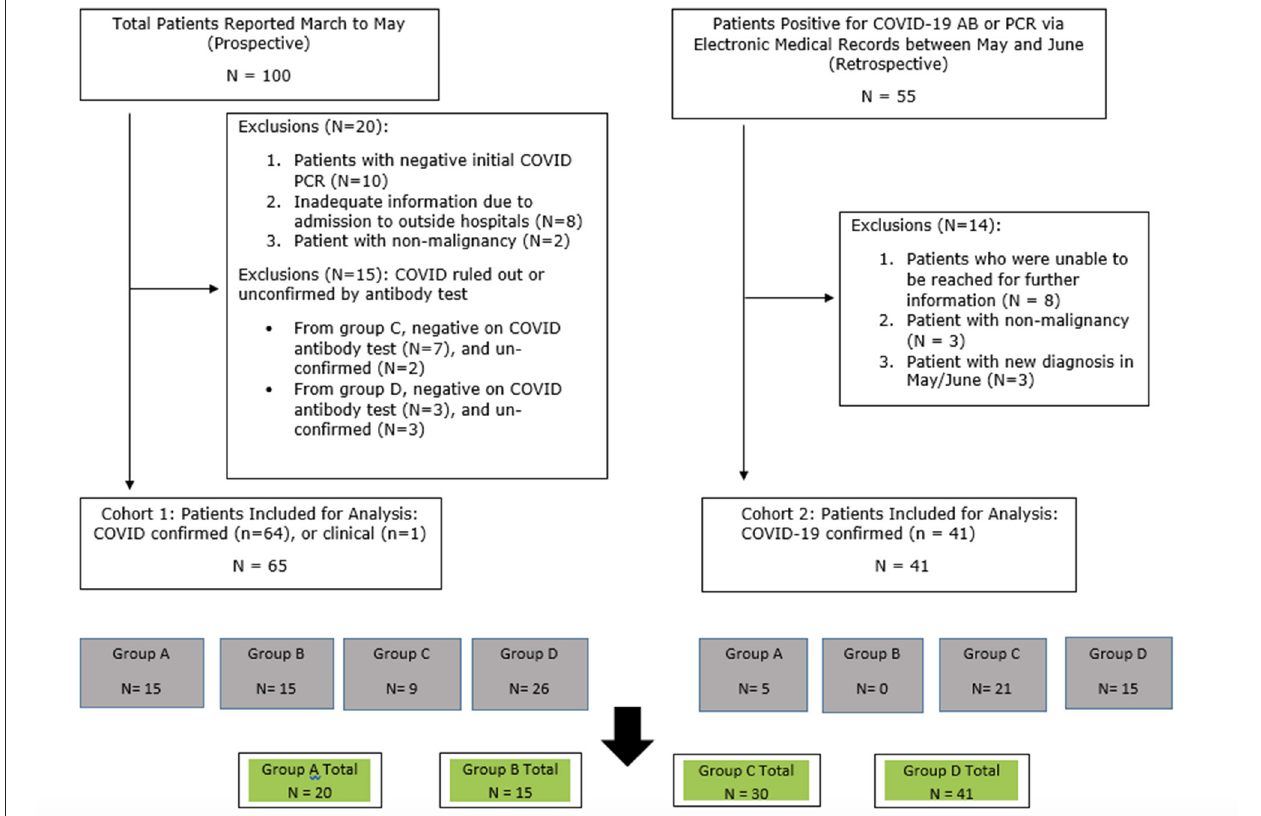
FIGURE 1 | Flow chart of patient